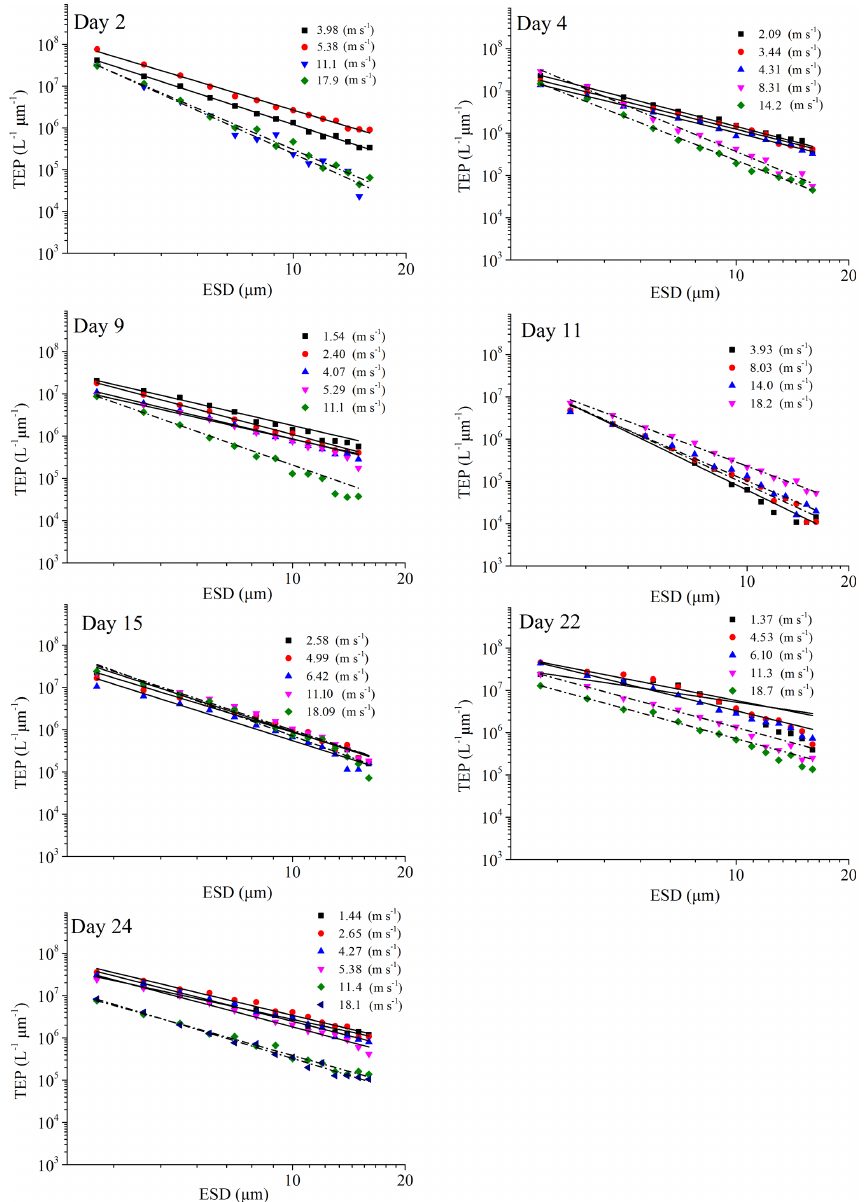
Figure 4. PSD of TEP SML at different wind speeds (linear regressions of log ( d N/ d (d p )) vs. log (d p ) was fitted to particles in the size range of 2–16µm ESD, with wind speeds < 8ms − 1 (solid line) and wind speeds > 8ms − 1 (dash and